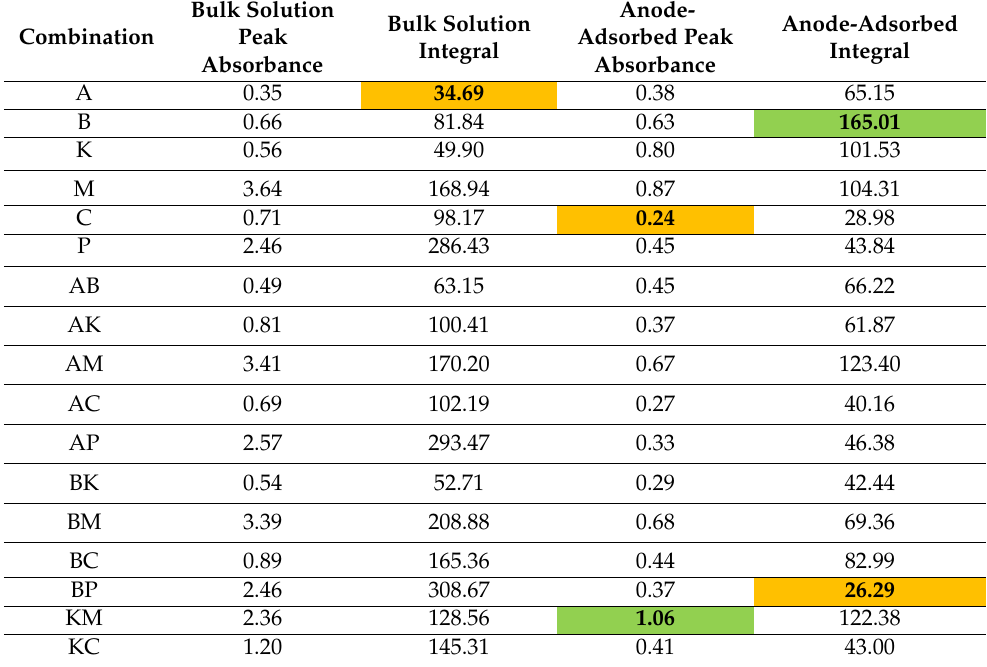
Table 2. Results of the bulk solution and anode-adsorbed UV-Vis analysis for all 42 dye combinations. Note that absorbance and the absorbance integral are unitless